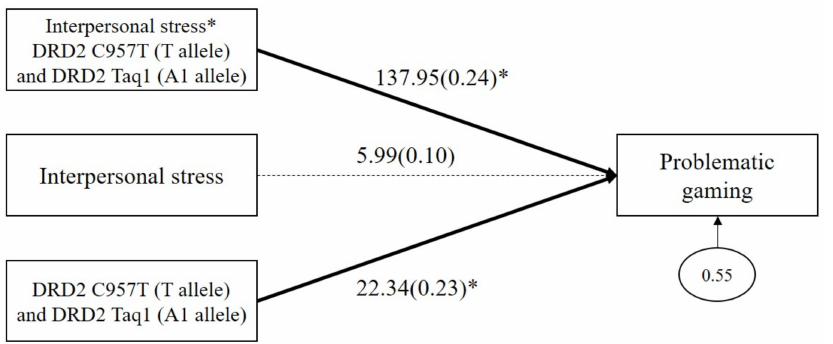
Figure 3. Interaction effect between combined DRD2 polymorphisms and interpersonal stress on problematic gaming. Sex, impulsivity, depression, anxiety, and ADHD were controlled for in all analyses (paths not shown for simplicity). Unstandardized (outside parentheses) and standardized (inside parentheses) coefficients are shown. Solid lines represent statistically significant coefficients. Dashed lines represent statistically insignificant coefficients; * p < 0.05.